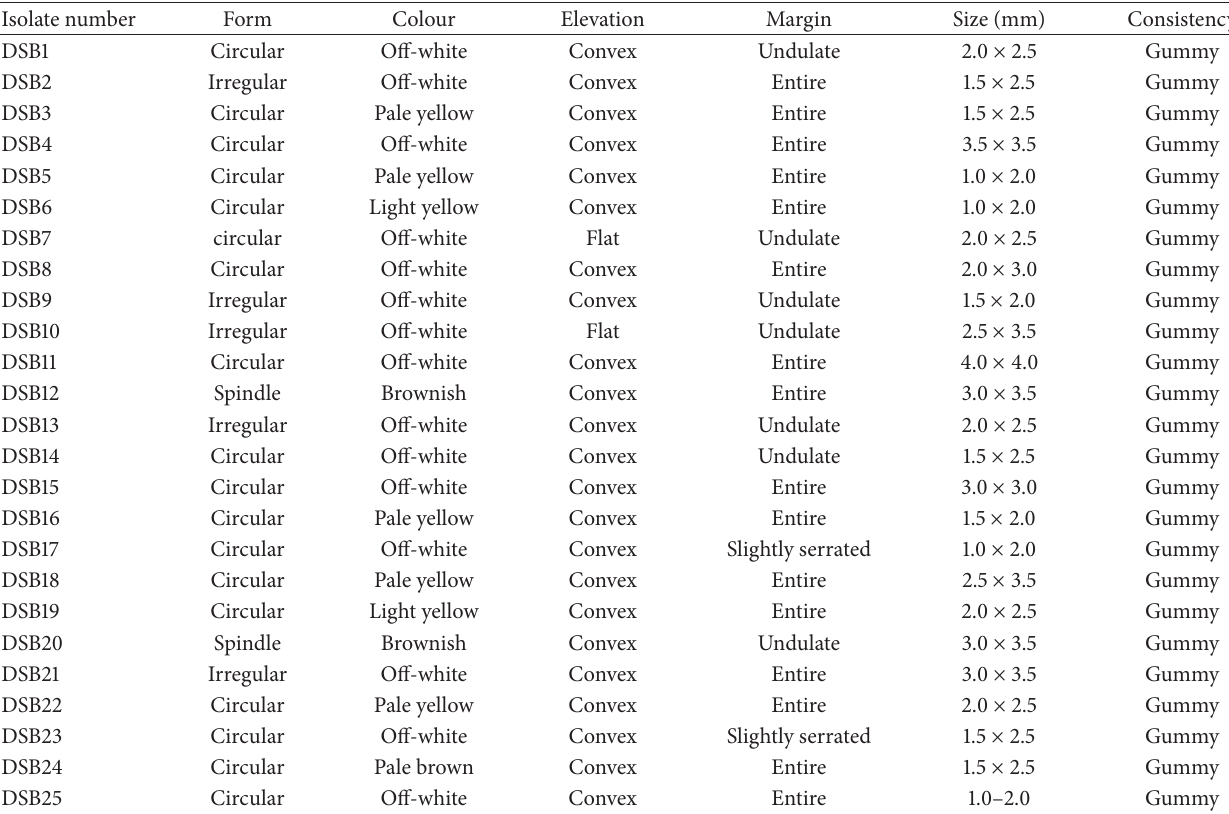
Table 2: Colony characteristics ∗ of the Bacillus spp. isolated from the coastal areas of Digha, West Bengal, India. Isolate